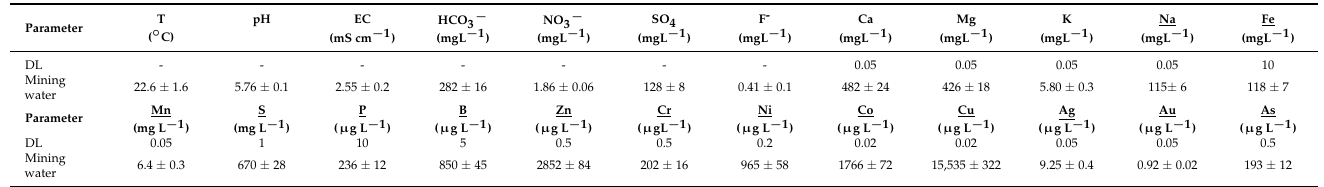
Table 1. Physicochemical characteristics of the acid mine water and their trace element, major anion and cation